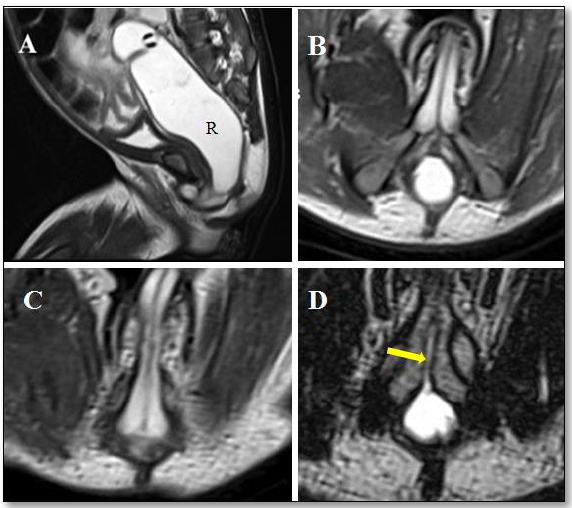
Figure 2: Intermediate ARM with rectourethral fistula in a 25 days old male child. A: T2W sagittal image shows the rectal pouch (R) terminating well below the PC plane but just above the I line. B: T2W axial image below PC plane shows well formed puborectalis muscles encircling the rectal pouch (R). C: T2W axial image below I plane shows the EAS muscle complex. D: T2 SPC axial image shows the anteriorly directed rectourethral fistulous tract (arrow) entering the bulbar urethra within the corpus spongiosum.